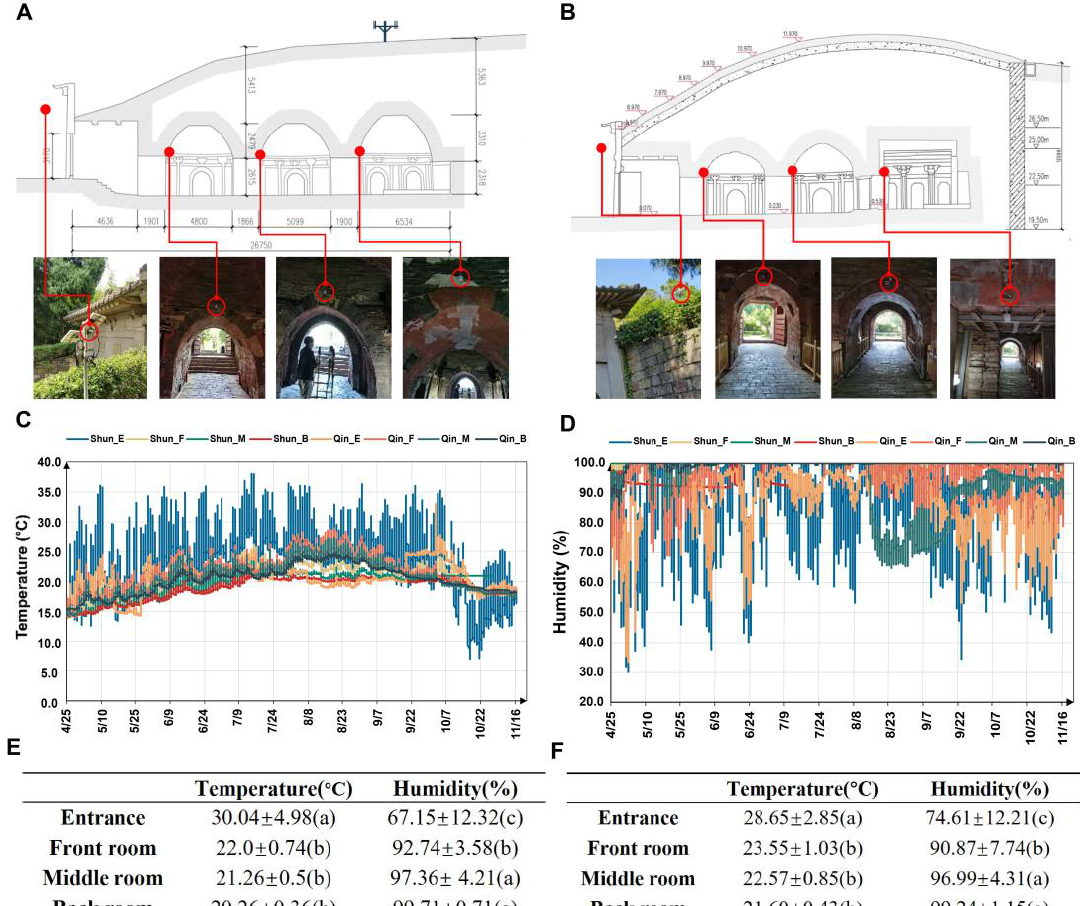
Figure 2. Monitoring data of temperature and humidity in the Shunling and Qinling Mausoleums. Electronic recorders were installed at different positions in Shunling ( A ) and Qinling Mausoleums ( B ). The temperature and humidity in Shunling ( C ) and Qinling Mausoleums ( D ) from 25 April to 6 November 2020. The temperature and humidity in Shunling ( E ) and Qinling Mausoleums ( F ) at sampling time. The values are the means of eight replicates (mean ± SD). The lowercase numbers ( A , B ) indicated the dimensions of Shunling and Qinling Mausoleums. Values followed by different lowercase letters ( E , F ) differ significantly ( p < 0.05). Abbreviations: Shun_E, Shunling entrance; Shun_F, Shunling front room; Shun_M, Shunling middle room; Shun_B: Shunling back room; Qin_E, Qinling entrance; Qin_F, Qinling front room; Qin_M, Qinling middle room; Qin_B, Qinling back room.